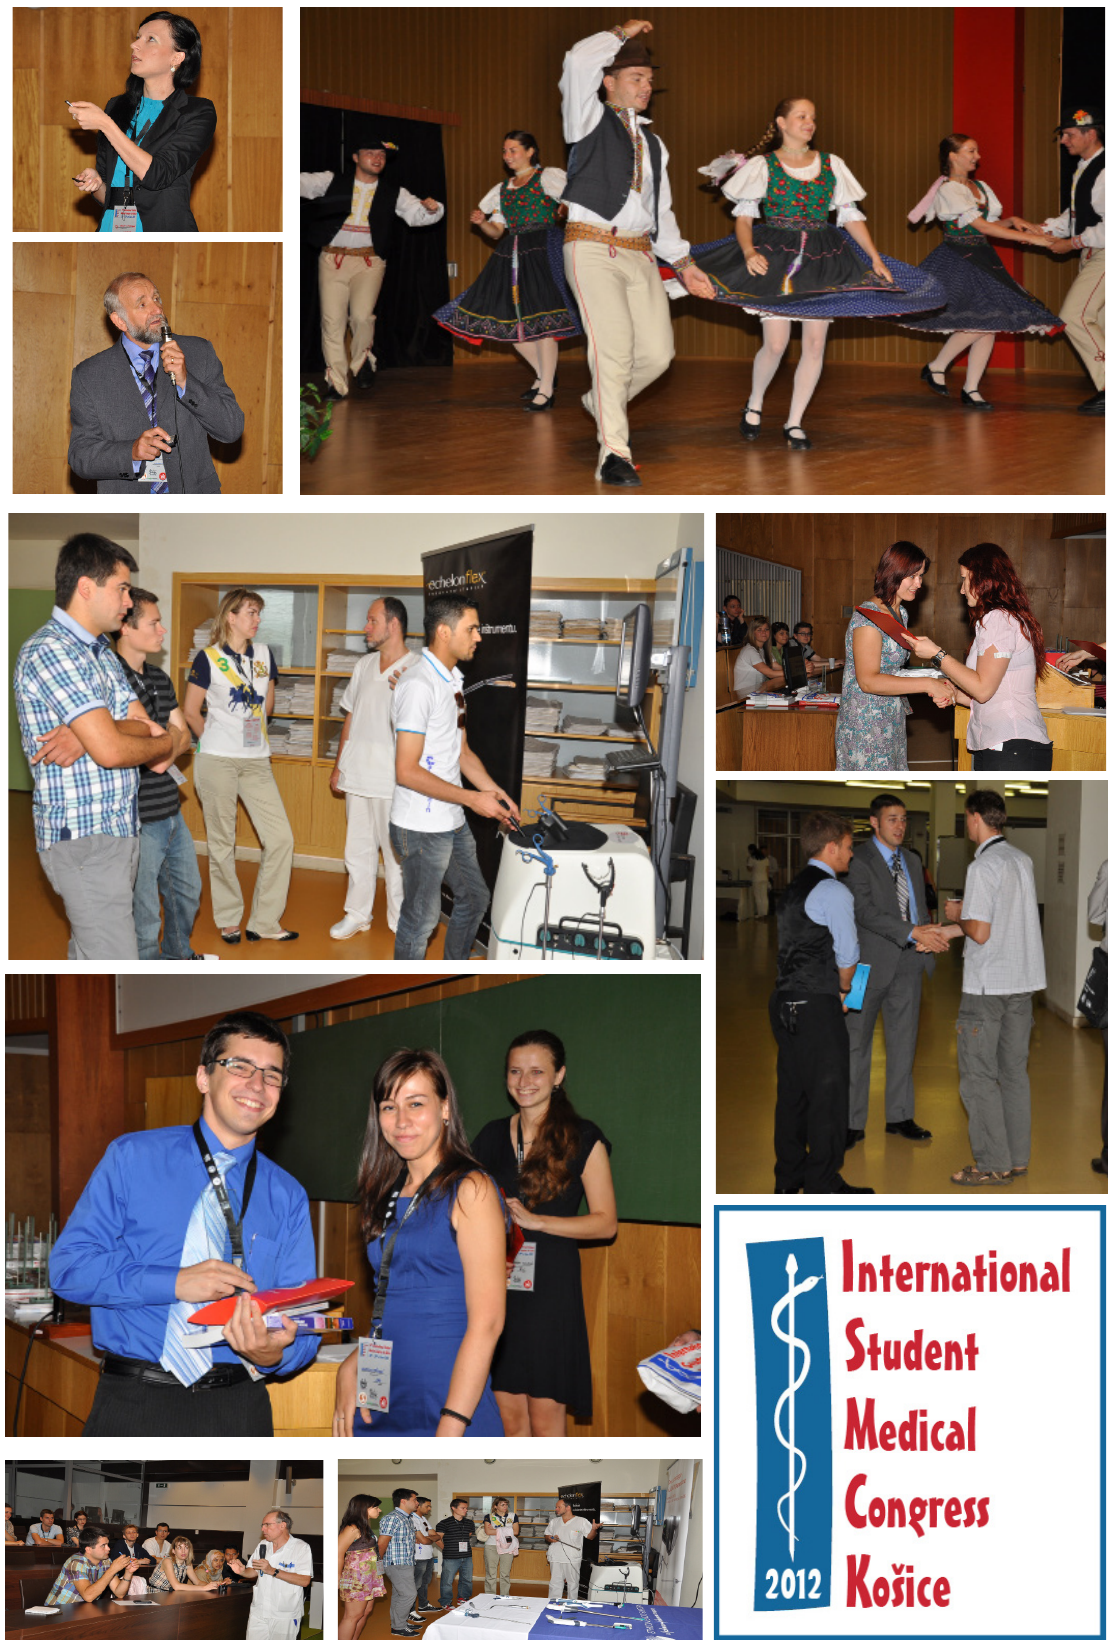
Figure 2. Photos of the 4th International Student Medical Congress in Ko š